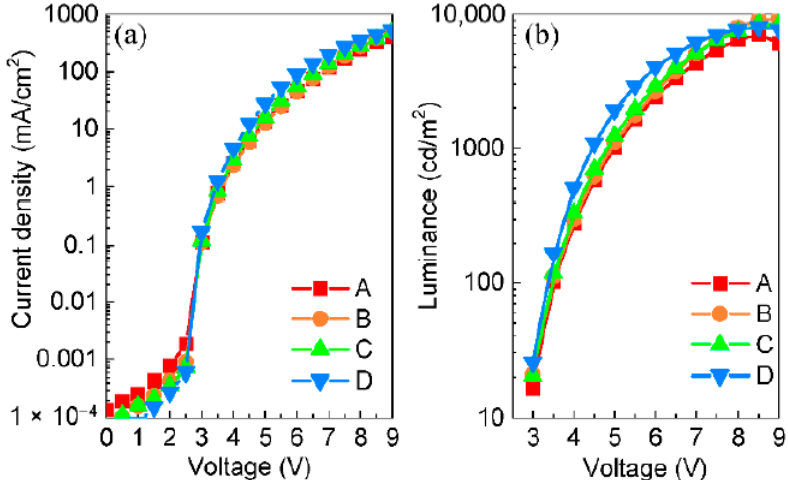
Figure 4. ( a ) Current density–voltage and ( b ) luminance–voltage curves of the